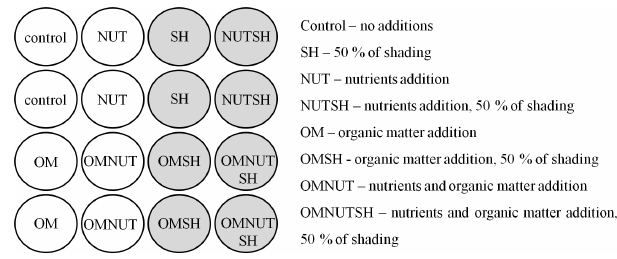
Figure 1. Schematic figure of the factorial design of mesocosms